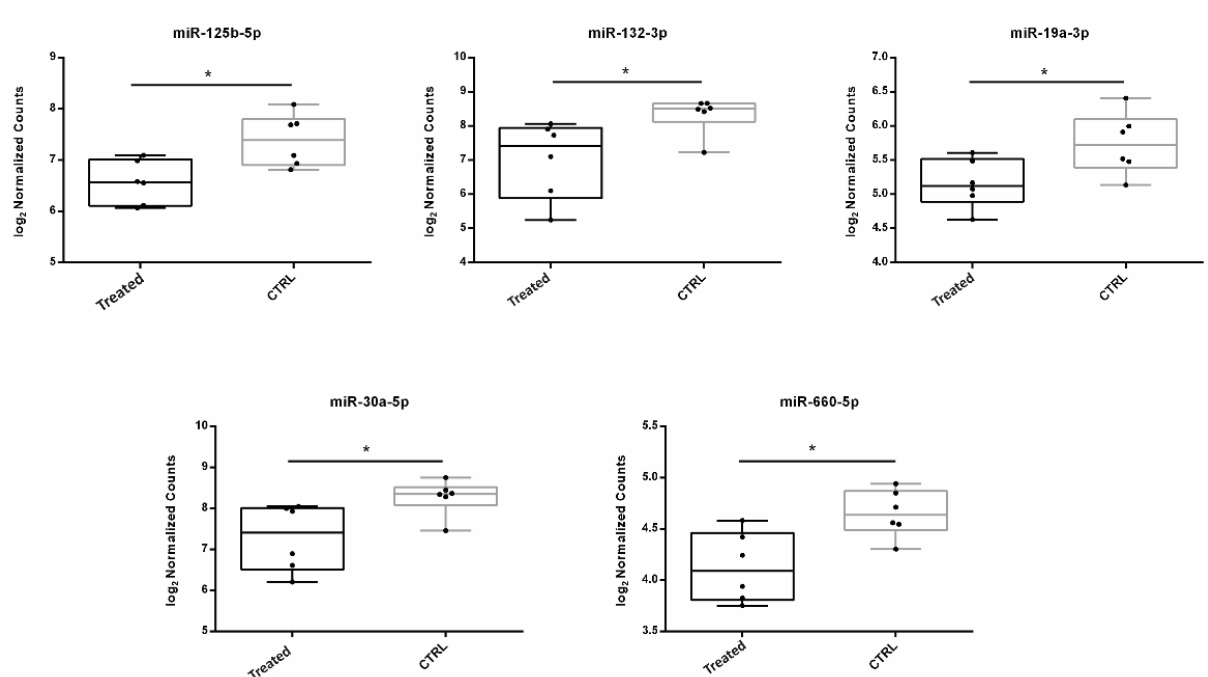
Figure 2. Relative expression of miRNAs in FF samples. DE miRNA relative expression in resveratrol treated FF samples vs. CTRL is shown by box-and-whisker plots. Expression data are represented as log2normalized counts. Significant p -values corrected for multiple testing by using the Benja-mini-Hochberg method are indicated by <<*>> (* p - value ≤ 0.05).